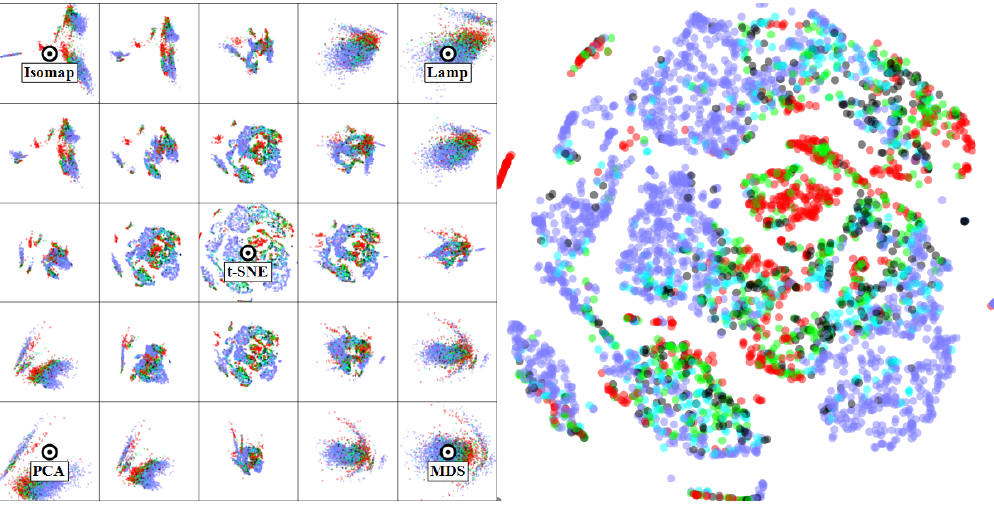
Figure 5. Software quality dataset (Section 4.1.1). No projection in the view space is able to separate well repositories of one kind from those of other